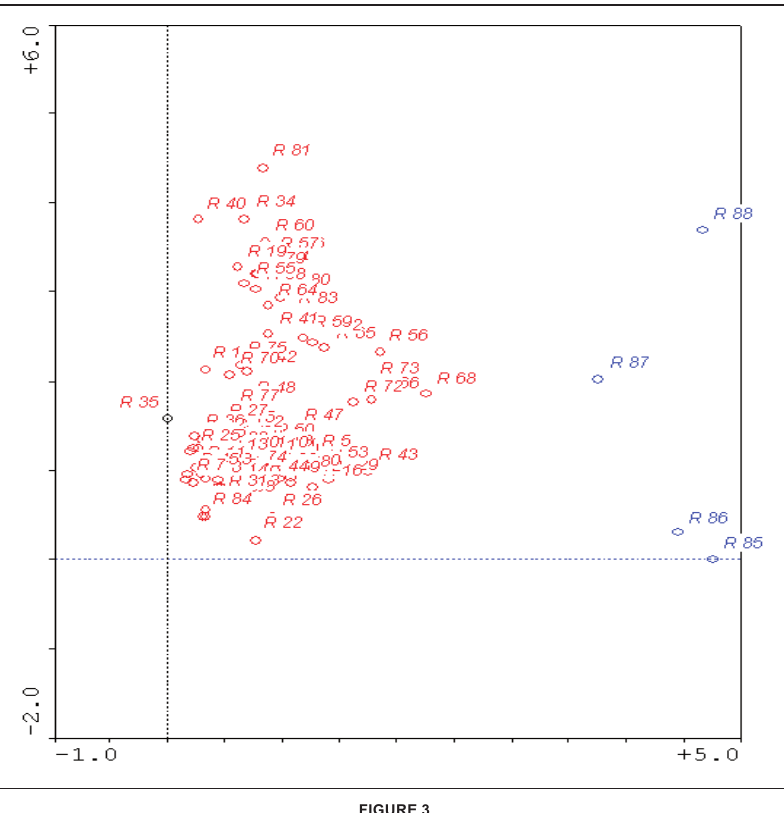
Figure 3 Detrended Correspondence Analysis (ter Braak & Šmilauer 1998) ordination of the complete data set of the Andover Game Reserve with a standard deviation (SD) of 4.77. Relevés highlighted in red represent Communities 1 and 2 and relevés highlighted in blue represent Community 3